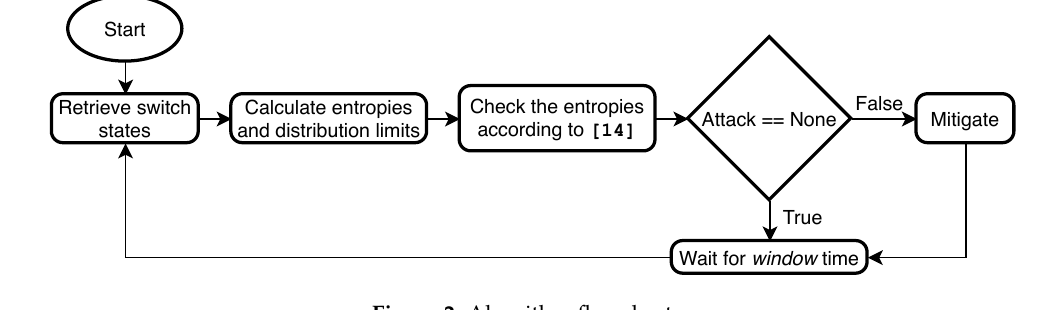
Figure 2. Algorithm